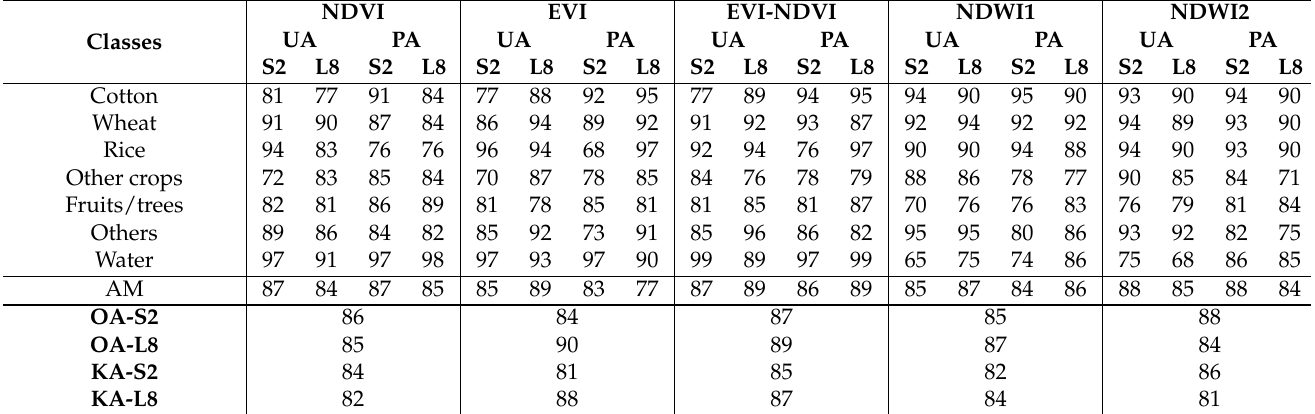
Table 6. Accuracy assessment (in %) results of RF